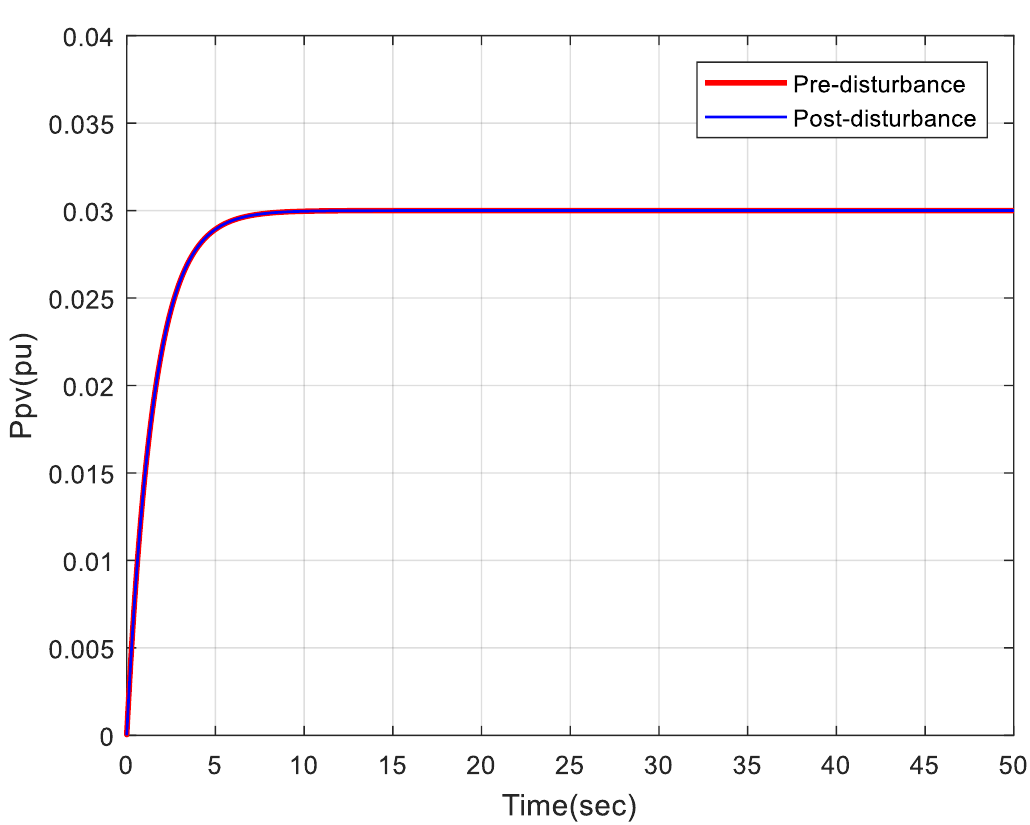
Figure 11. Photovoltaic power (pre- and post-disturbance).